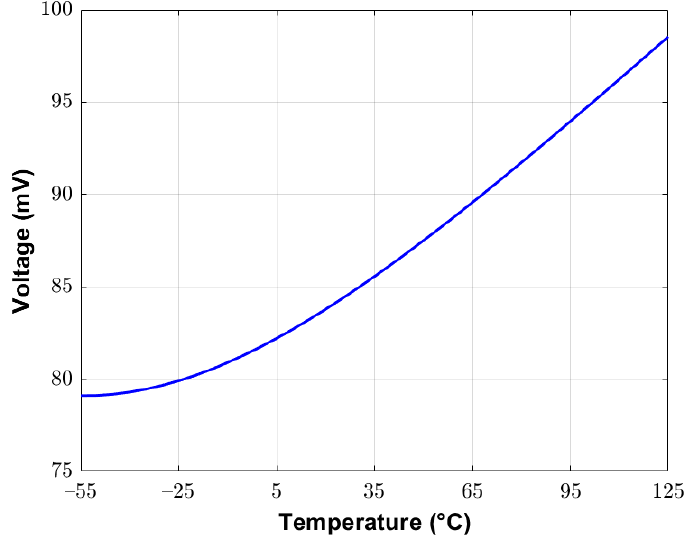
Figure 8. Simulated Δ V gs vs. temperature, for two nMOSs working in their subthreshold region. The schematic is shown in Figure 7, when m = 4, K = 2, between −55 and 125 °C, for TT corner, using a 55 nm CMOS technology.